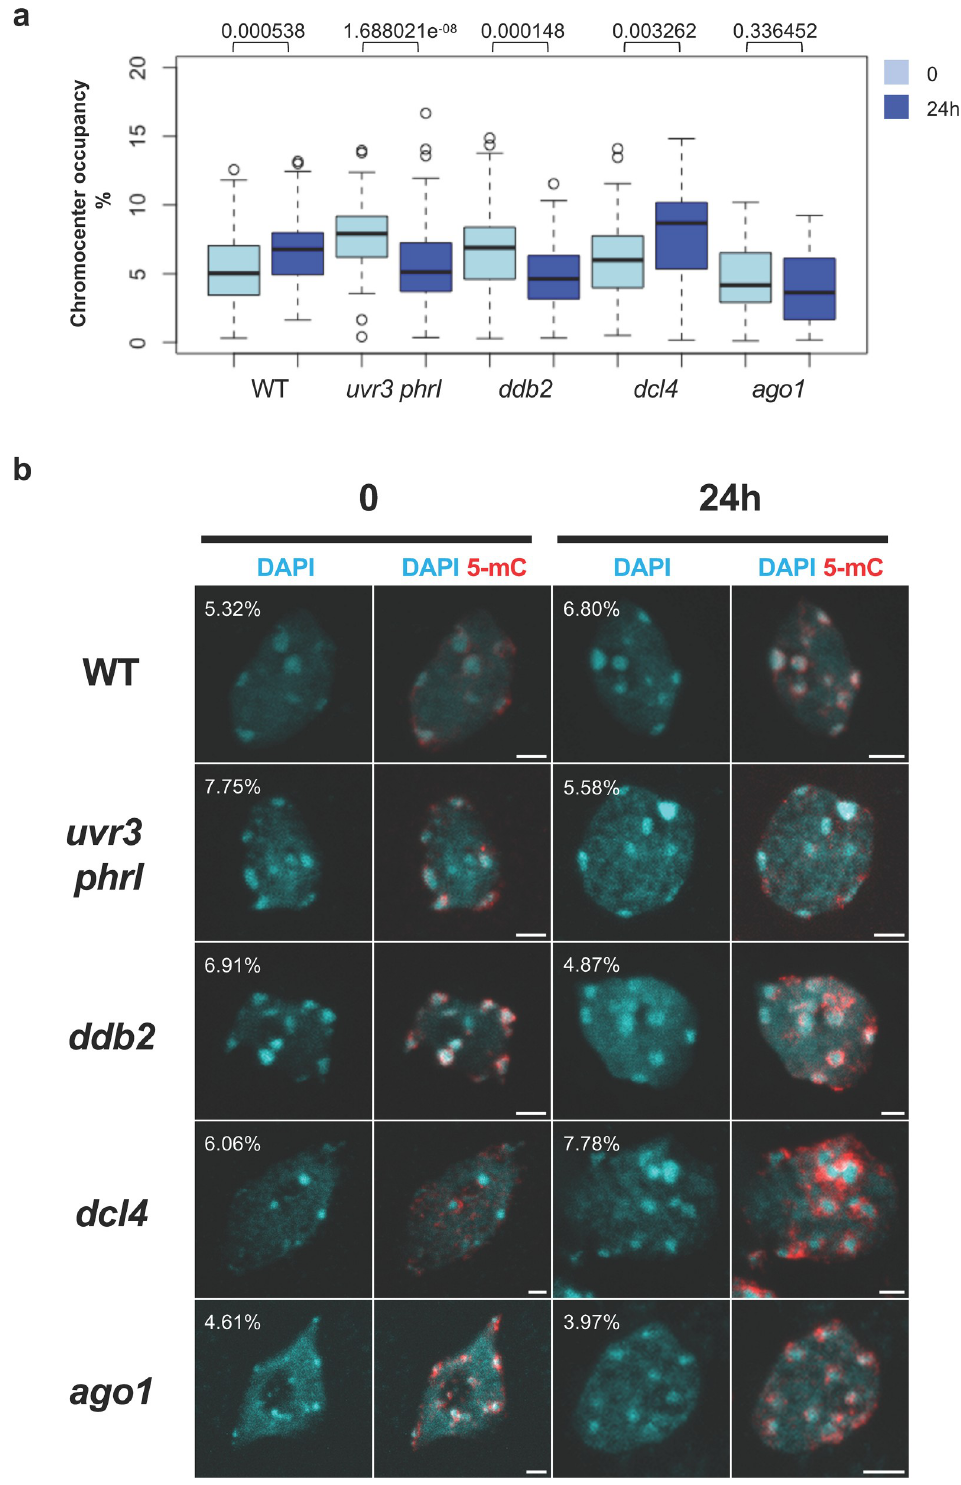
Fig 2. Chromocenters and 5-mC phenotypes upon UV-C exposure. a Boxplots representing the percentage of Chromocenters Occupancy (CO) in WT, uvr3 phrI , ddb2 , dcl4 and ago1 plants before (0) and 24h upon UV-C exposure. CO was determined using DAPI staining, confocal microscopy and measured with an automated image quantification program. Exact p values according Mann Whitney test are indicated above each graph. Number of nuclei